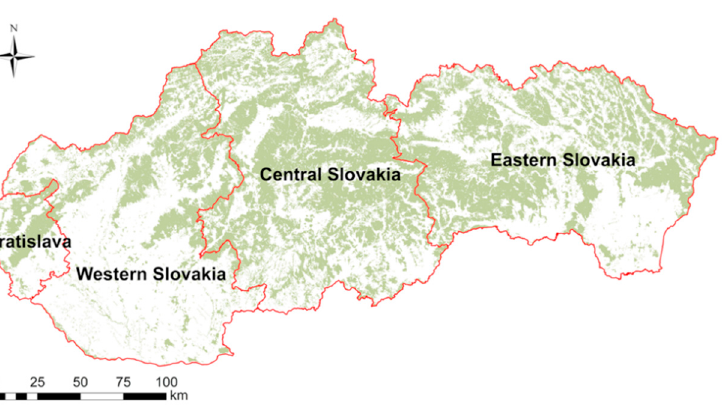
Figure 1. Forest coverage in geographical regions of Slovakia: Bratislava (3.7%), Western Slovakia (19%), Central Slovakia (42%), and Eastern Slovakia (35.3%).